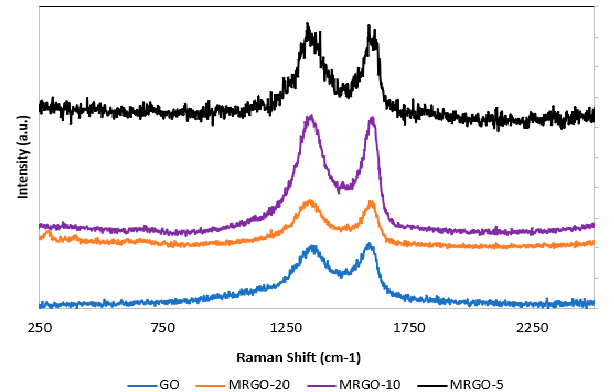
Figure 5. Raman analysis of GO, MRGO-5, MRGO-10 and MRGO-20. Table 4. I D /I G ratio of GO, MRGO-5, MRGO-10 and MRGO-20. I D /I G